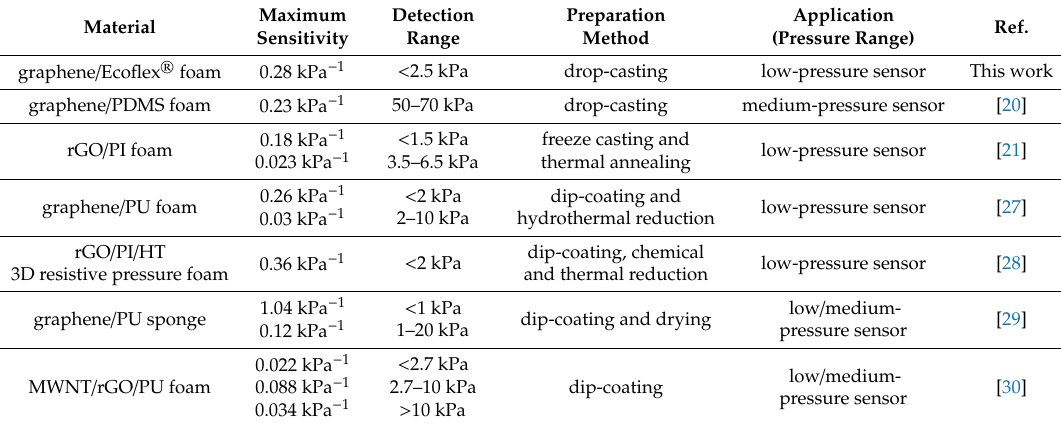
Table 1. Comparison between our sensor and the main pressure sensors present in the literature.